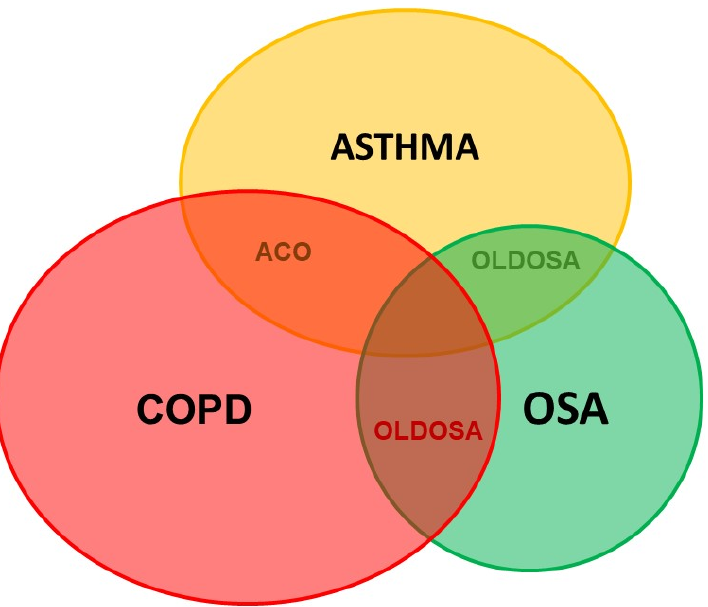
Figure 3. Comorbid obstructive lung disease and obstructive sleep apnea. ACO: Asthma–COPD overlap; COPD: chronic obstructive lung disease; OSA: obstructive sleep apnea; OLDOSA: obstructive lung disease and obstructive sleep apnea.